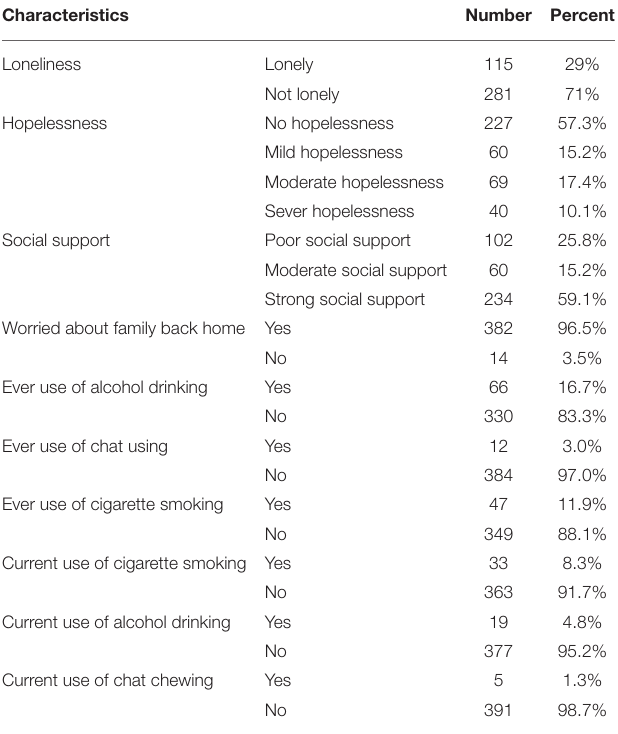
TABLE 3 | Psychosocial and substance use-related characteristics of respondents in Mai-Aini, Eritrean refugee camps, Tigray, northern Ethiopia, 2020.